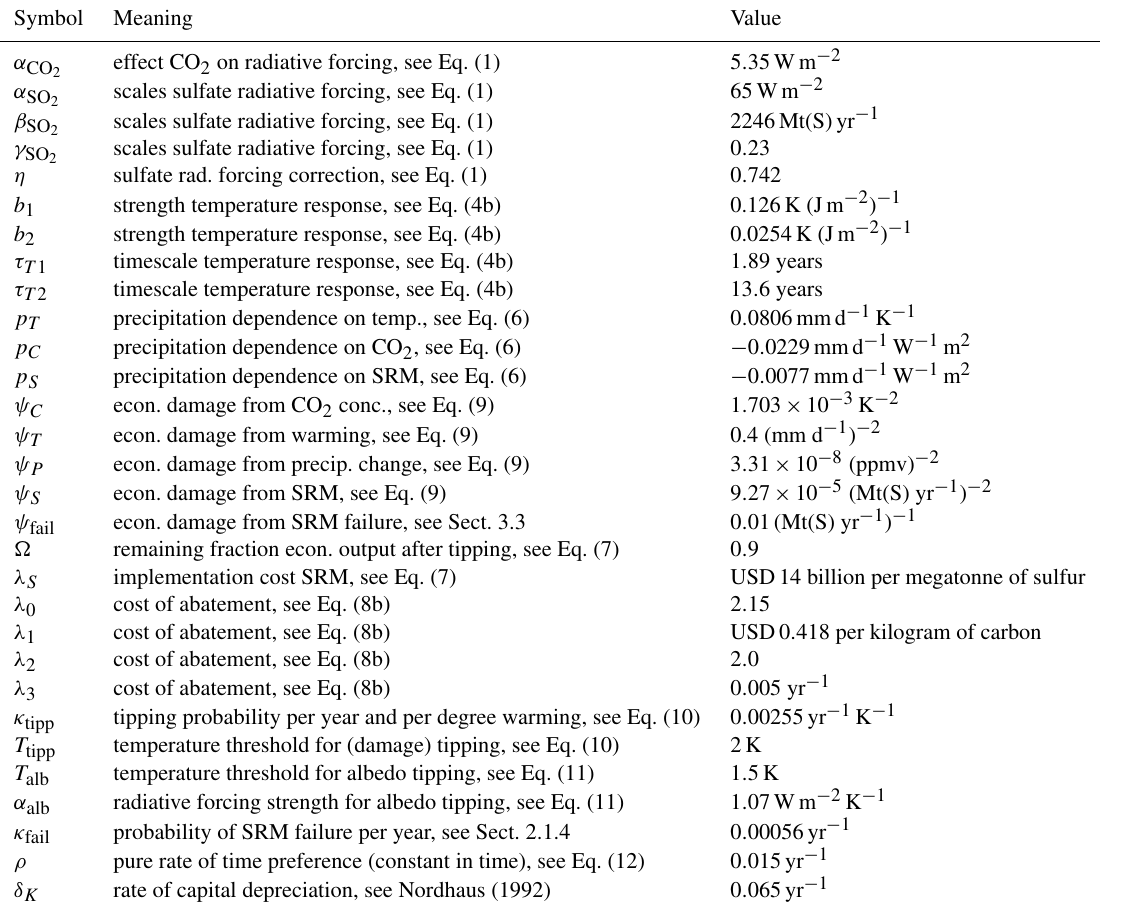
Table 1. Model parameters of the GeoDICE model related to the representation of SRM. The carbon model parameters can be found in Table 5 of Joos et al. (2013), and others in DICE or DSICE (Cai et al.,